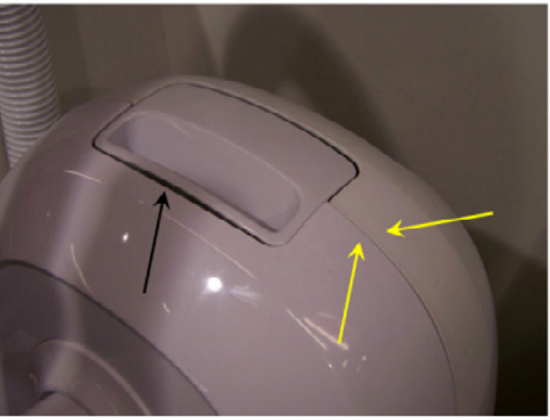
Fig. 2. A deviation from the intent of the designer